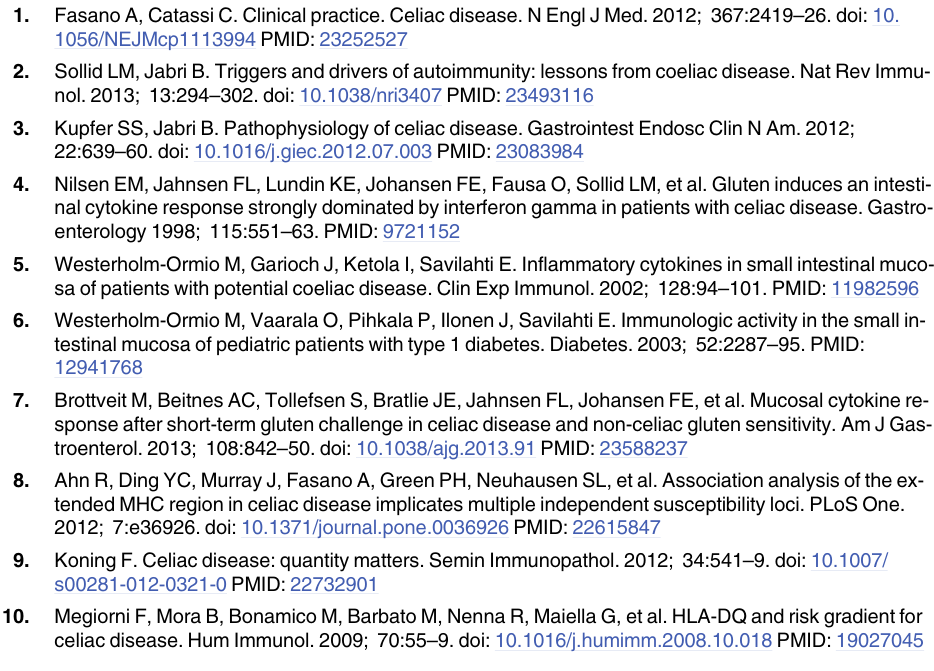
S1 Table. Primers used for TNFRSF1A DHPLC and sequence analyses. S2 Table. Association between HLA and TNFA , IFNG and TNFRSF1A gene polymor- phisms. S3 Table. Binary logistic regression analyses made considering CD diagnosis as outcome variable, while HLA-DQ haplotypes, the carriage of TNFA and IFNG rare alleles in homo- zygosis (recessive effect) or in heterozygosis (dominant effect) were predictor variables. S4 Table. Haplotypes resulting from the combination of TNFA -1031T > C, -857C > T, -376G > A and -308G > A polymorphisms (Arlequin). The OR with 95% CI were calculated with respect to the most frequent haplotype (TCGG)[36]. S5 Table. TNFA haplotype